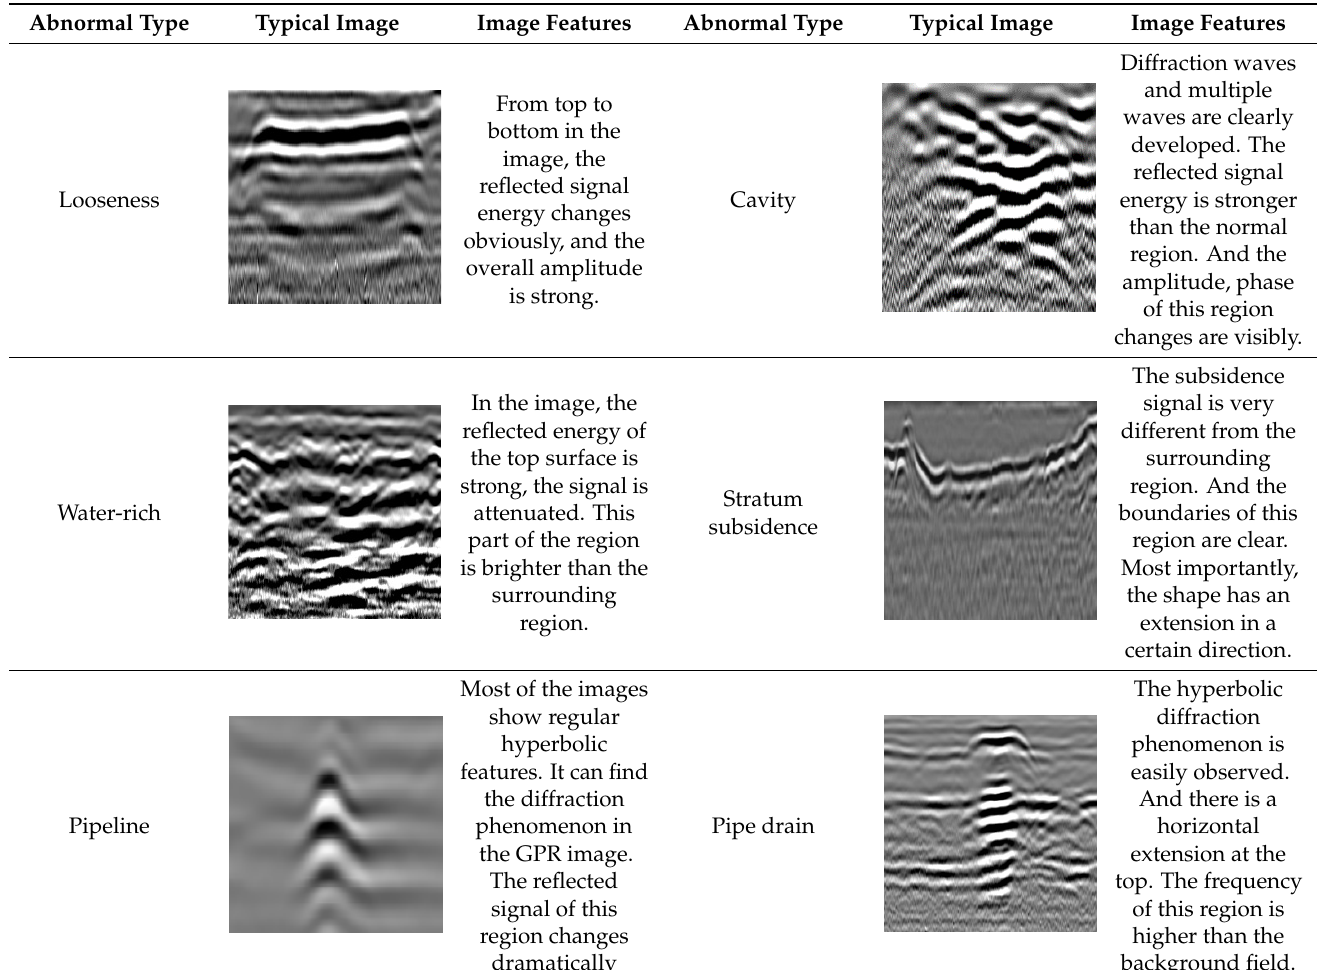
higher than the background